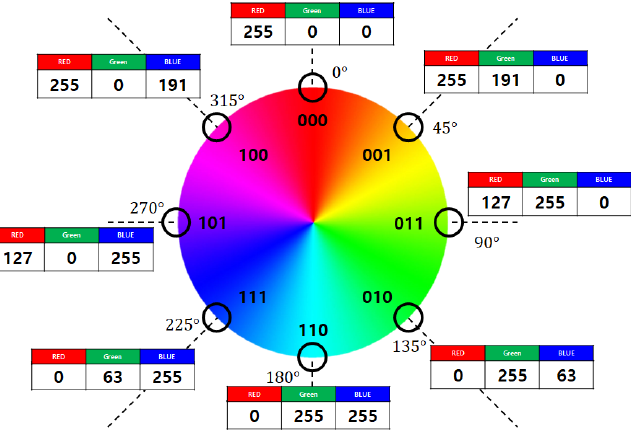
Figure 2. The color constellation for Complementary Color Barcode-based OCC. When the proposed technique transmits data through the display, color barcodes must be continuously configured so that the primary color and the complementary color are paired. If the R, G, B-encoded symbols are transmitted, the actual data stream is RR’GG’BB’, where R, G, and B denote the encoded symbols and R’, G’, and B’ denote the complementary colors. The receiver uses the image captured while filming the display using a rolling shutter camera. Theoretically, when capturing the image at half the speed of the display’s output, a color barcode formed by pairs of primary and complementary colors appears as a single captured image. As shown in Figure 1, for example, if the transmitter’s screen refresh rate is 60 Hz, and the receiving end captures it at 30 fps, the six transmitted frames (R, R’, G, G’, B, B’) appear at the receiver as three incoming images, RR’, GG’, and BB’, but are perceived as a white bar to the human